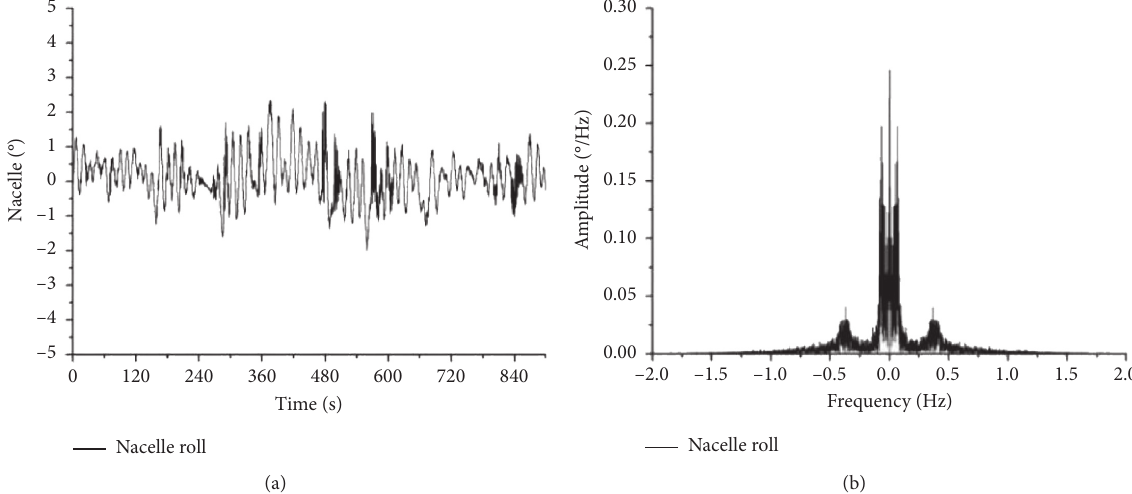
Figure 12: (a) The roll angle change of hot-air balloon basket. (b) The rolling spectrum change of hot-air balloon